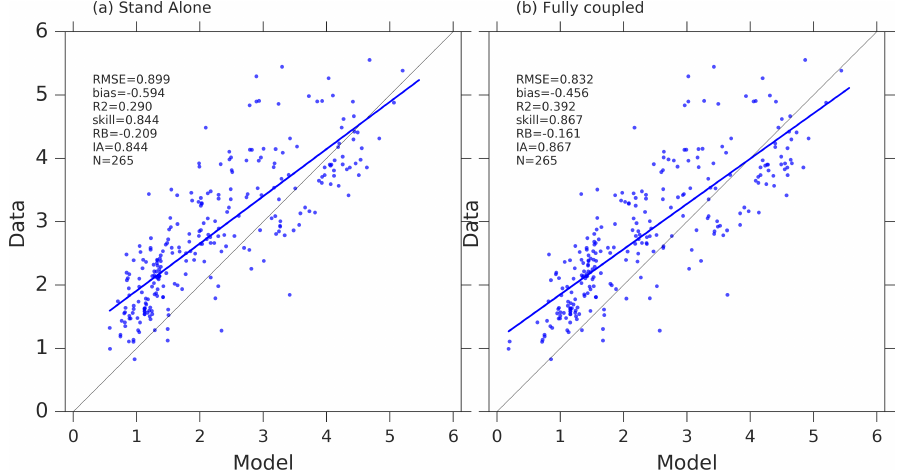
Figure 16. Statistical comparisons of High Water Mark observations and model results. Location